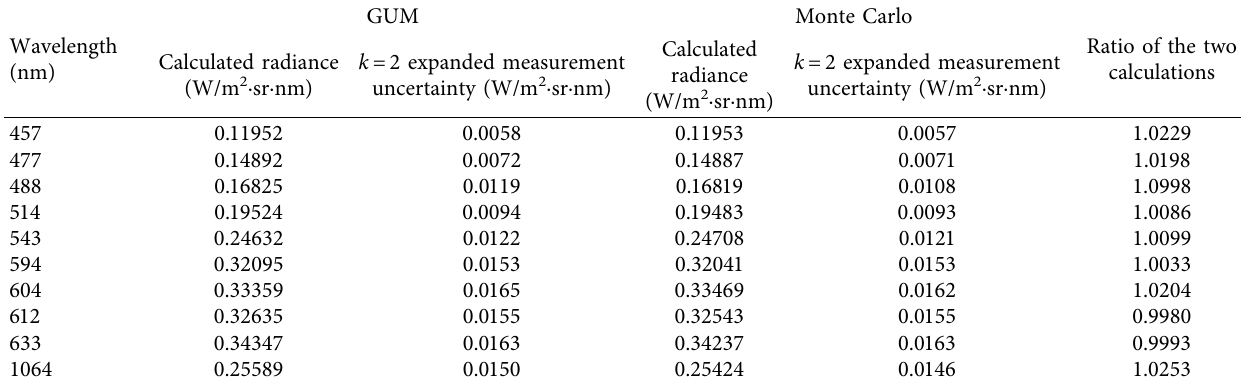
Ratio of the two